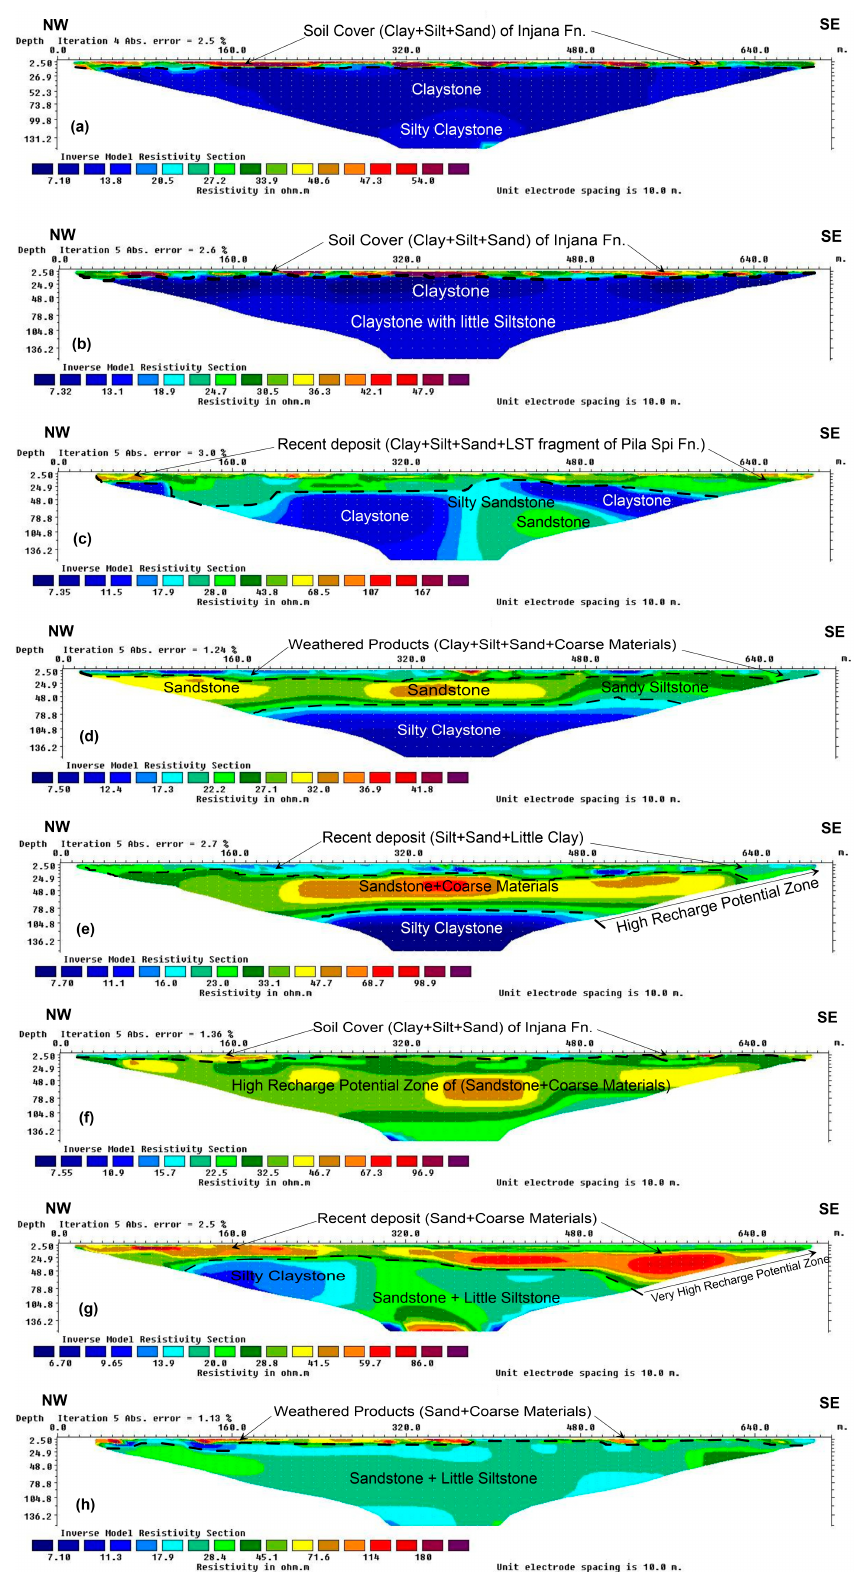
Figure 8. Resistivity inversion profiles in the Sangaw sub-basin. ( a , b ) low to very low, ( c ) moderate, ( d ) moderate to high, ( e , f ) high, and ( g , h ) very high groundwater potential zones.